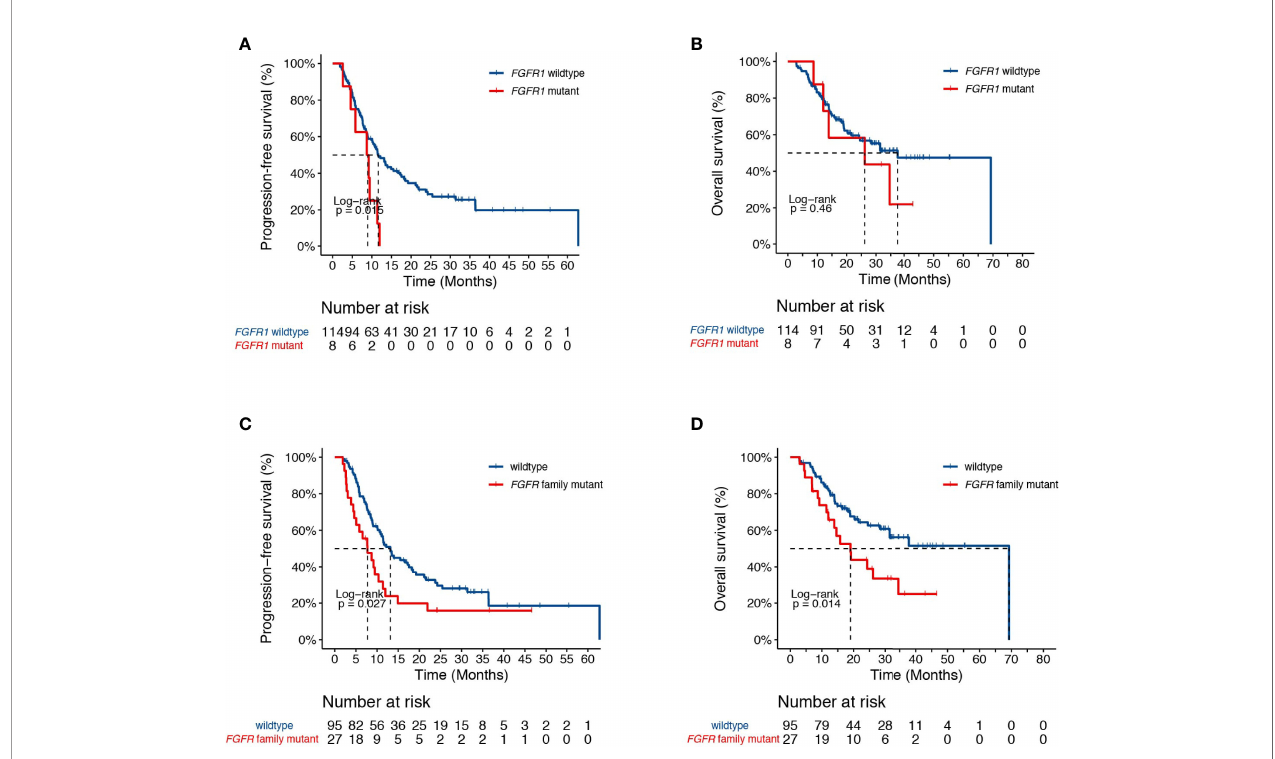
FIGURE 3 | Associations of dCRT survival outcomes with the FGFR pathway. (A, B) Kaplan-Meier estimates of (A) PFS and (B) OS in the full analysis set comparing patients with and without FGFR1 alterations. (C, D) Kaplan-Meier estimates of (C) PFS and (D) OS in the full analysis set comparing patients with and without alterations in the FGFR family